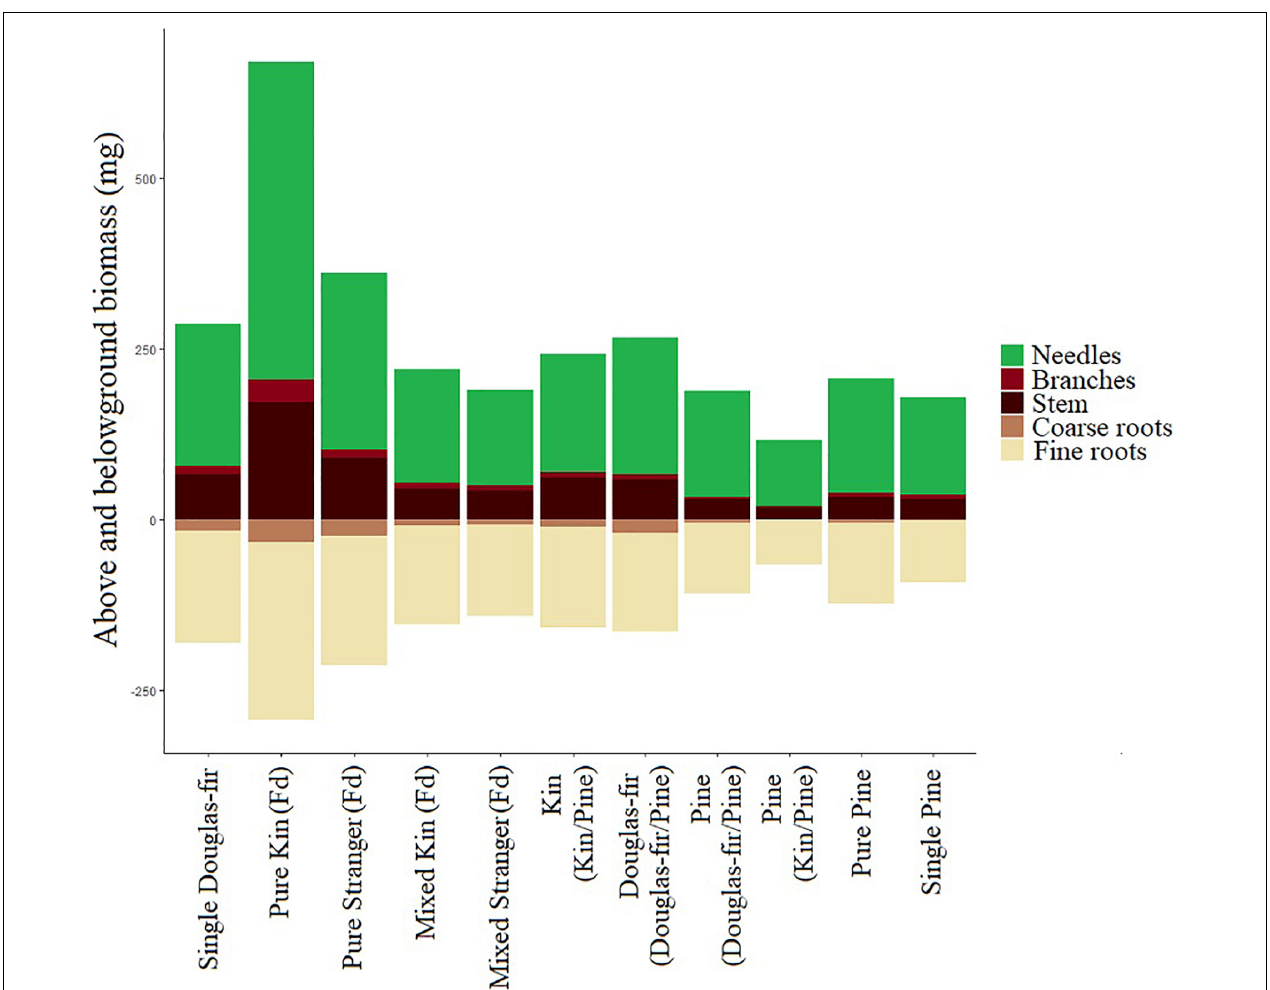
FIGURE 11 | Mean mass (mg) of seedling needles, branches, stem, coarse roots, and fine roots by neighborhood type. Aboveground biomass is presented as mg above zero and belowground as mg below zero. Aboveground mass is the mean dry weight and belowground mass was estimated by total root weight multiplied by the proportion of the root system by volume that was coarse or fine roots per seedling and then